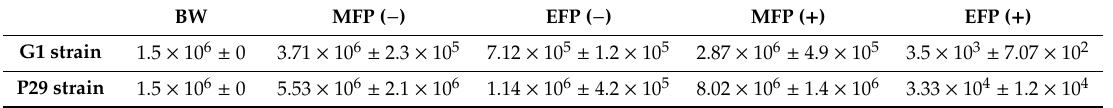
Table 1. Amount of viable cells in the studied conditions (CFU /